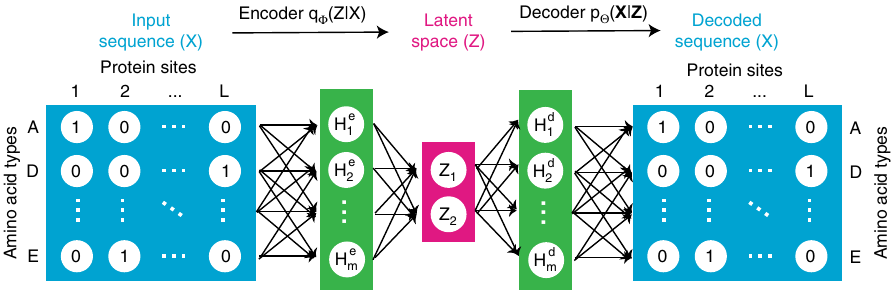
Fig. 1 Encoder and decoder models used in variational auto-encoders. Both encoder and decoder models used in this paper are fully connected arti fi cial neural networks with one hidden layer H . The encoder model transforms each protein sequence X into a distribution q ϕ ð Z j X Þ of Z in the latent space; the decoder model transforms each point in the latent space Z into a distribution p θ ð X j Z Þ of X in the protein sequence space. Protein sequences from a multiple sequence alignment with L amino acids are represented as a 21 ´ L matrix whose entries are either 0 or 1 based on a one-hot coding scheme. Gaps in sequences are modeled as an extra amino acid type. Therefore, there are 21 amino